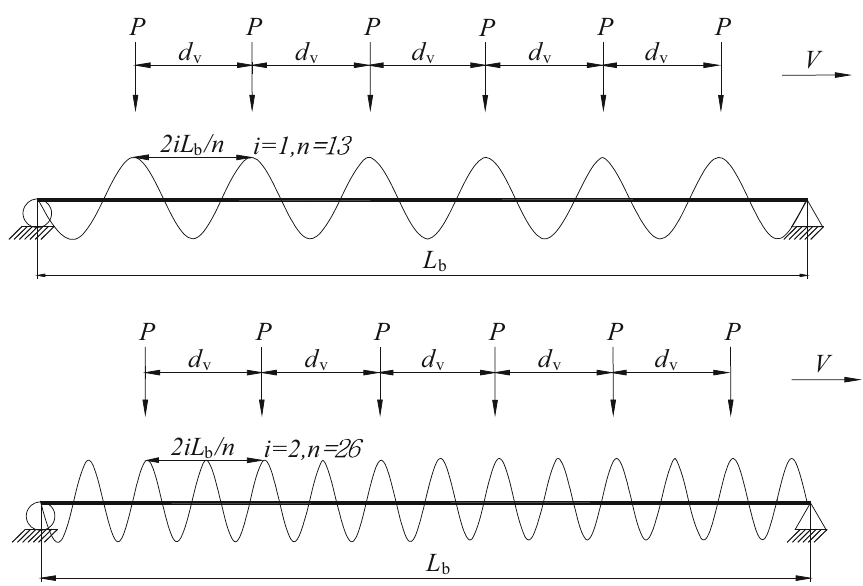
Fig. 7 Sketch map of the condition when generalized force of a simply supported beam reaches its extreme